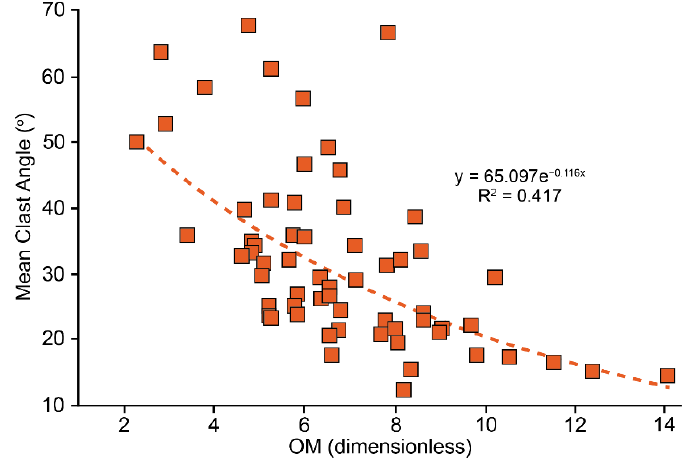
Figure 10. Exponential correlation between our new Organization Metric (OM) and armor clast angles to sediment surface for all sites sampled in western Prince William Sound in 2010.